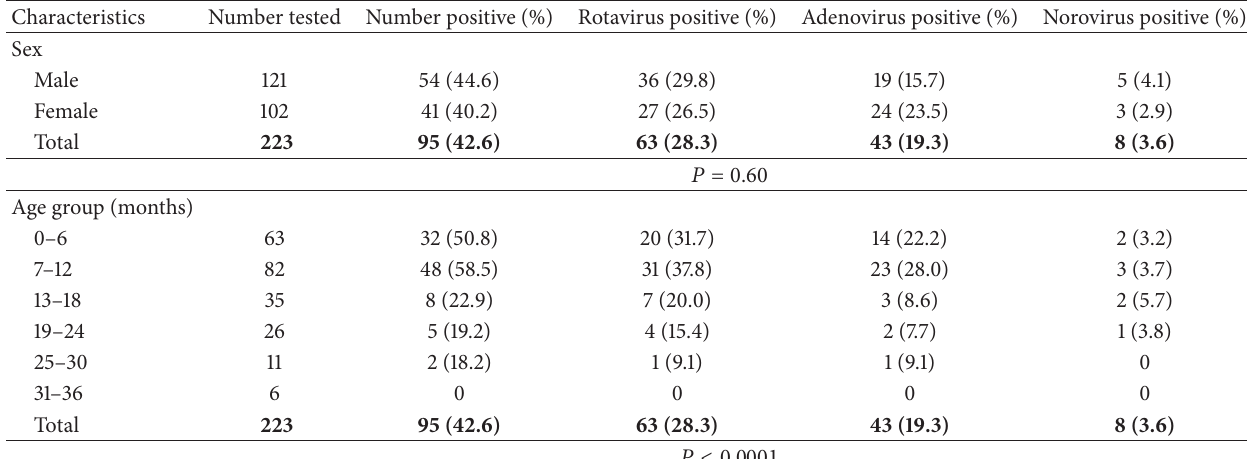
Table 2: Sex and age distribution of viral enteropathogens.